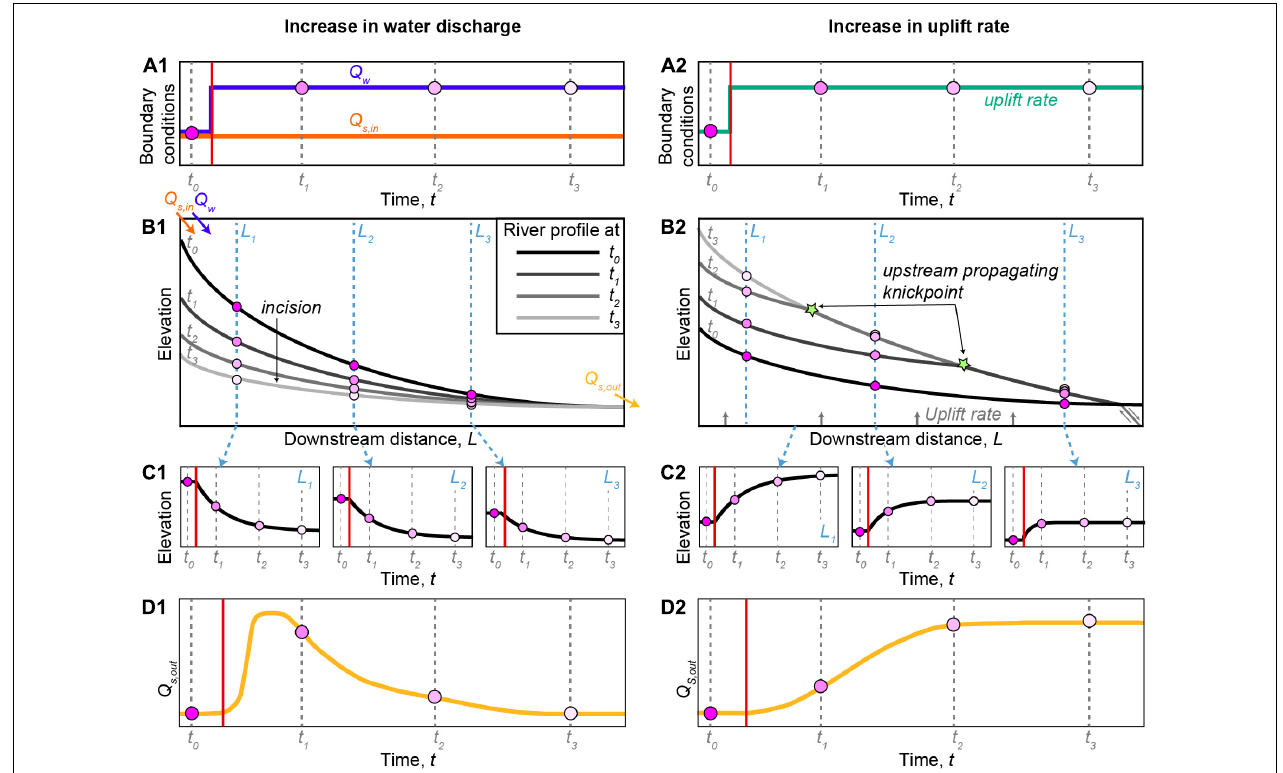
FIGURE 3 | Conceptual response of the fluvial system to an increase in upstream water discharge, Q w , relative to upstream sediment supply, Q s , in (left panel) or an increase in uplift rate of the entire region relative to a fixed base level (right panel). (A) A step increase in either water discharge (A1) or uplift rate (A2) occurs between the two points in time t 0 and t 1 . (B) In response, the longitudinal river profiles adjust by incision along the entire profile (B1) or by elevating the river bed combined with an upstream migrating knickpoint (B2) . (C) The change in river bed elevation through time is displayed in detail for three locations along each profile L 1 to L 3 . (D) In addition to the topographic response of the landscape (B,C) , signals are generated; for example, in the form of changes in sediment discharge at the basin outlet, Q s , out . An increase in upstream Q w results in a temporary increase in Q s , out (D1) . In contrast, an increase in regional uplift rate results in a sustained increase in Q s , out (D2) . This conceptual figure represents a summary of experimental and numerical works (see text for